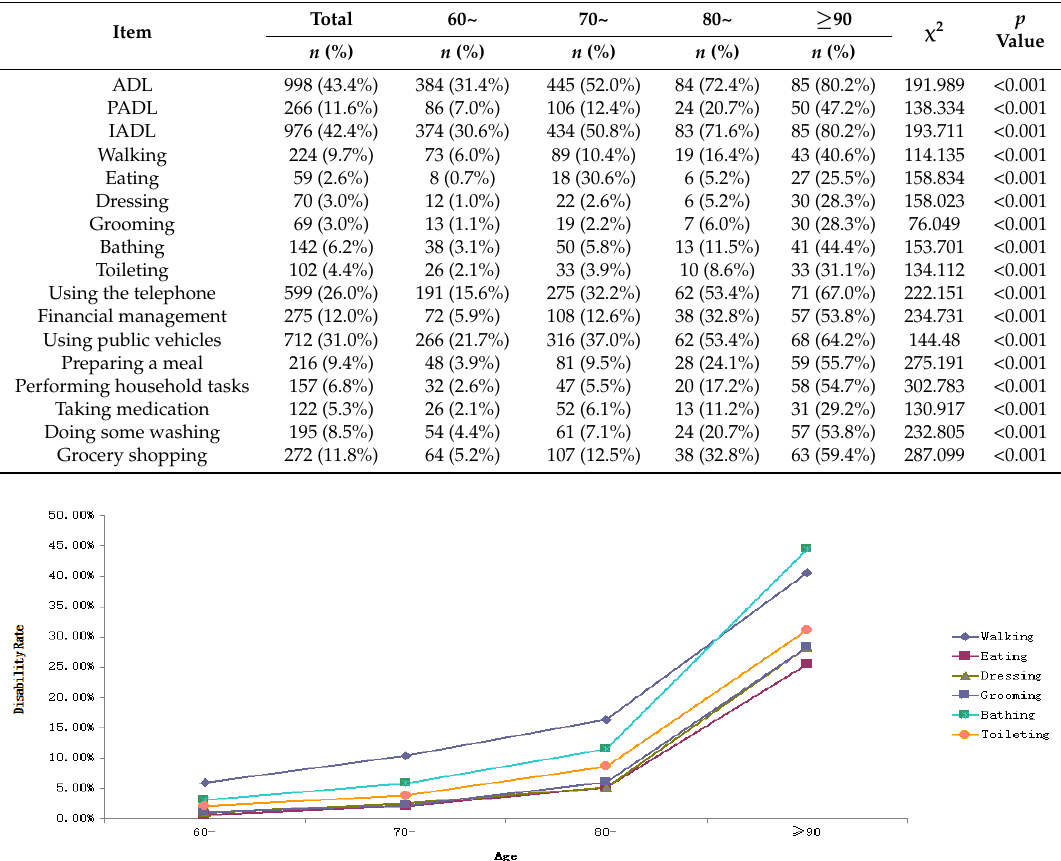
Figure 2. Disability rates of six items of PADL in the elderly at different ages.